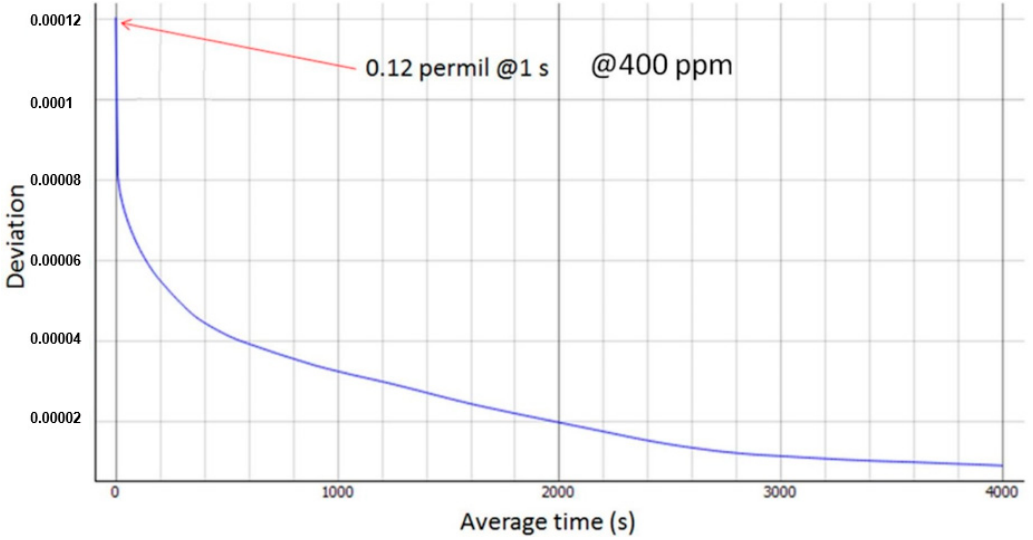
Figure 4. Allan deviation vs. average number plot shows the long term stability is improved after periodic calibration with standard reference gases. periodic calibration with standard reference